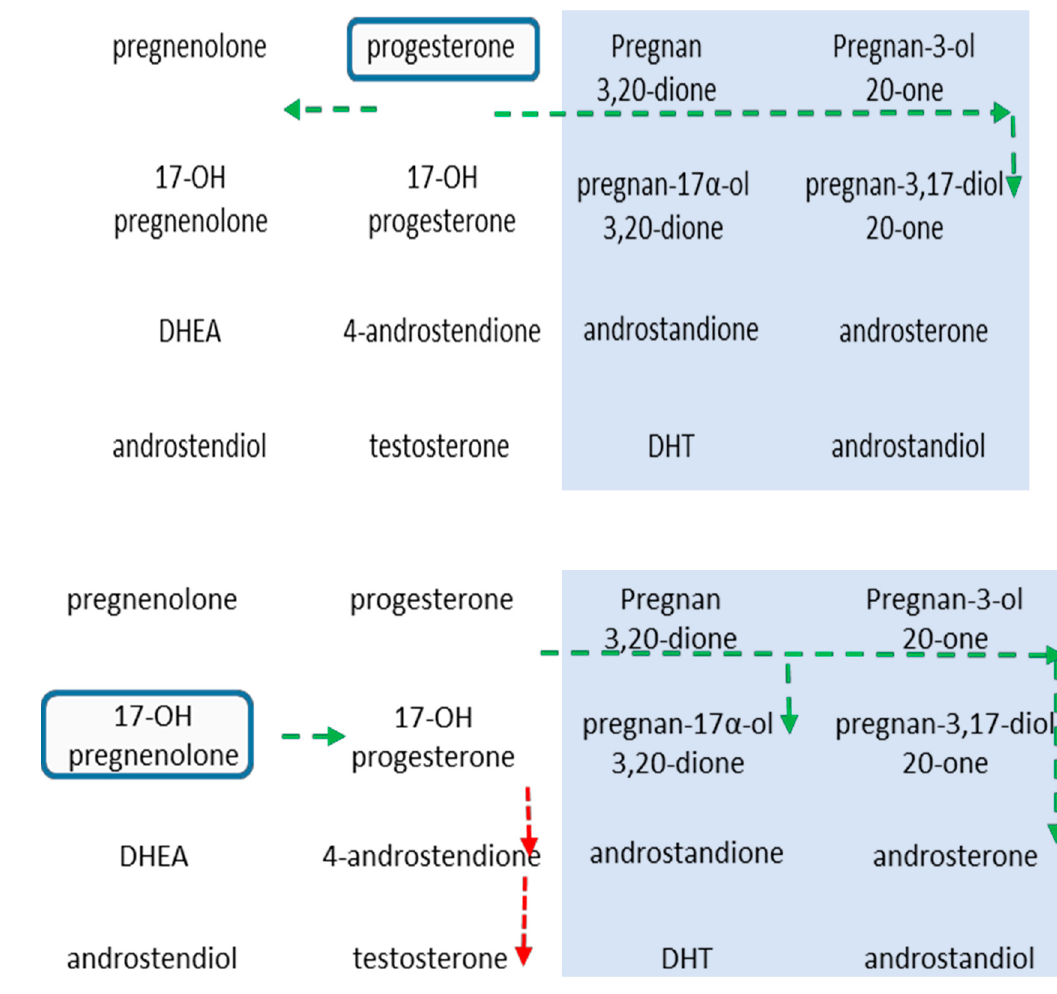
Figure 3. Schematic representation of steroidogenesis in human prostate cancer tissues following incubations with ( A ) pro- gesterone and ( B ) 17-OH-pregnenolone. The rectangular boxes show the starting point for the respective steroid substrates. The first two columns (unshaded) of each scheme represent the classical pathways and the last two columns (shaded) depict the backdoor pathway steroids. Green arrows—increased levels. Red arrows—decreased levels. The arrows indicate the direction of the reaction, either increasing or decreasing for a particular steroid.